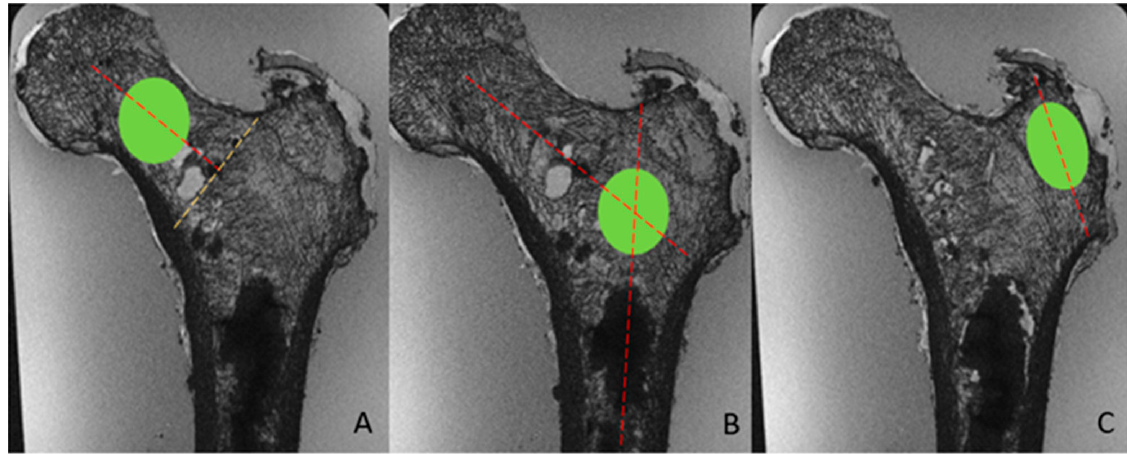
Figure 3. Examples of ROI on MR Image. ( A ): neck placement in the middle of a line passing through the neck axis, joining the femoral head physis and a perpendicular line passing through the inter- section of the great trochanter physis and neck cortical bone (yellow dashed line). ( B ): intertrochan- teric placement at the intersection of the lines passing through the axis of the diaphysis and the neck. ( C ): greater trochanter placement in the middle of a line corresponding to the vertical axis of the greater trochanter.